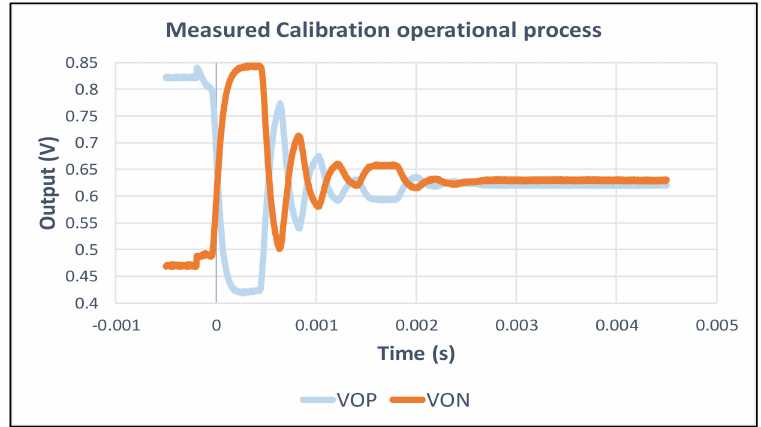
Figure 27. The measurement results of the calibration circuit.